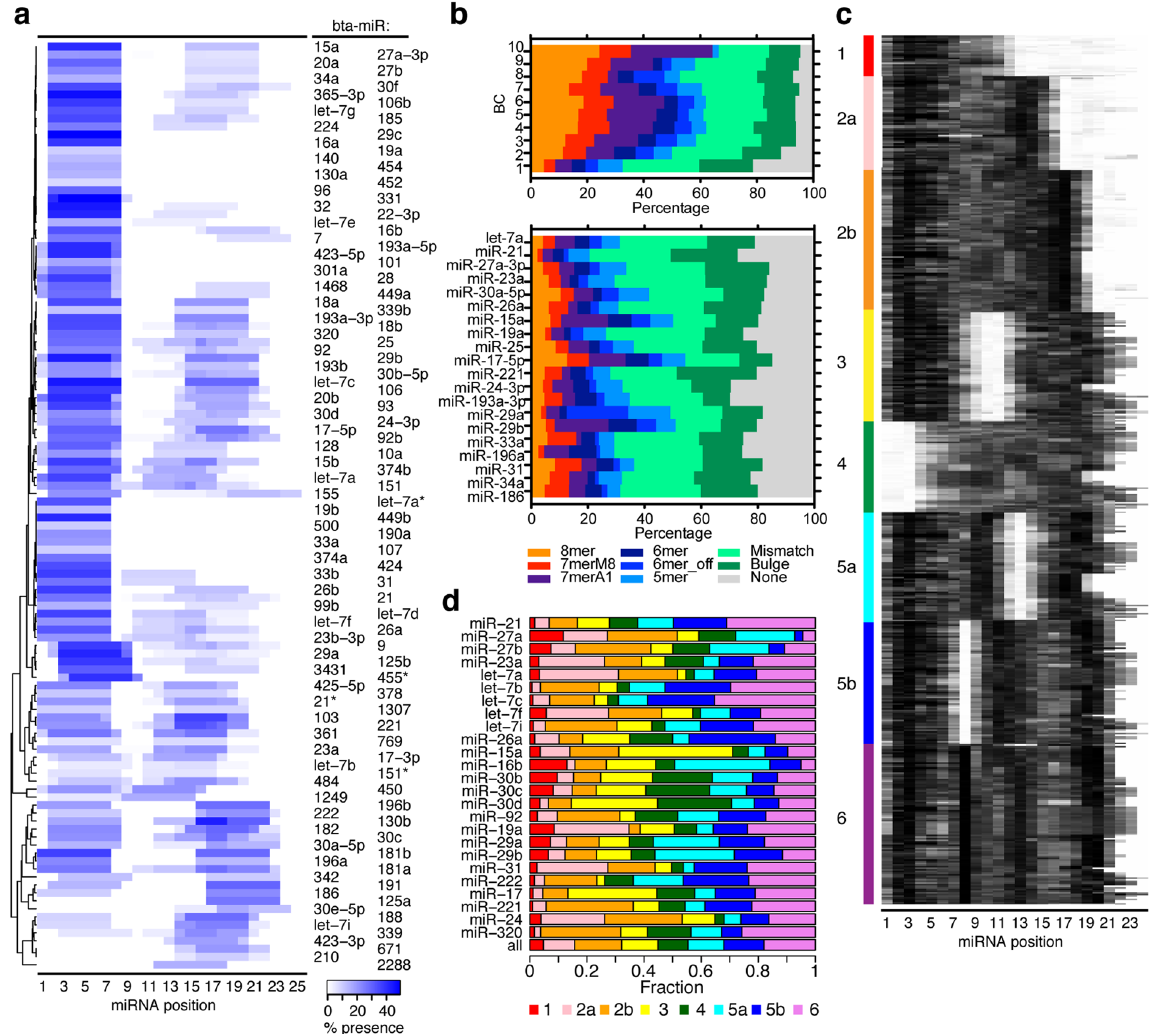
Figure 4. miRNA pairing rules for bovine miRNAs. (a) De novo analysis of cognate miRNA-complementary- enriched 7mer motifs in chimera target regions plotted as a heat map across the miRNA. miRNAs are ordered by hierarchical clustering. Coloring is proportional to percent-wise motif presence. (b) The proportion of chimera-defined target regions with the indicated seed variants is plotted, broken down by chimera BC (top) or the most abundant miRNAs (bottom). (c) miRNA–target duplex structure predictions represented as heat maps. Black pixels indicate base pairing. Structures were partitioned by k-means clustering into eight groups. Interactions from all transcript regions were included in this analysis. (d) Distribution of the identified clusters for the most abundant miRNAs. miRNAs were grouped by seed site family and ranked by decreasing